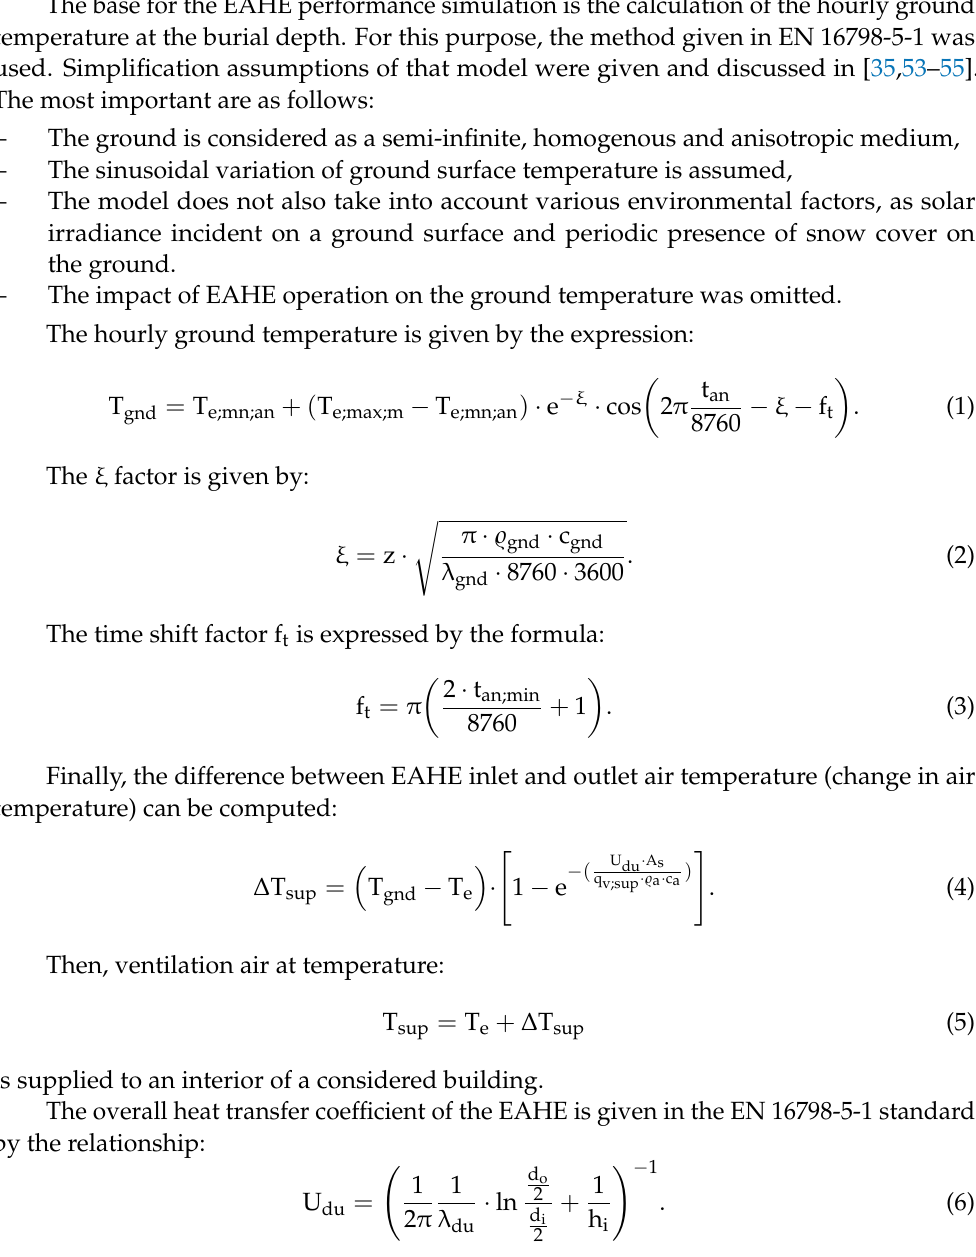
Table 1. Parameters of the earth-to-air heat exchanger. Parameter Symbol Value Unit Duct length L 30 m Air velocity in the duct v 0.957 m/s Outer pipe diameter d o 0.200 m Inner pipe diameter d i 0.182 m Average burial depth z 2.0 m Thermal conductivity of the duct λ du 0.27 Density of the